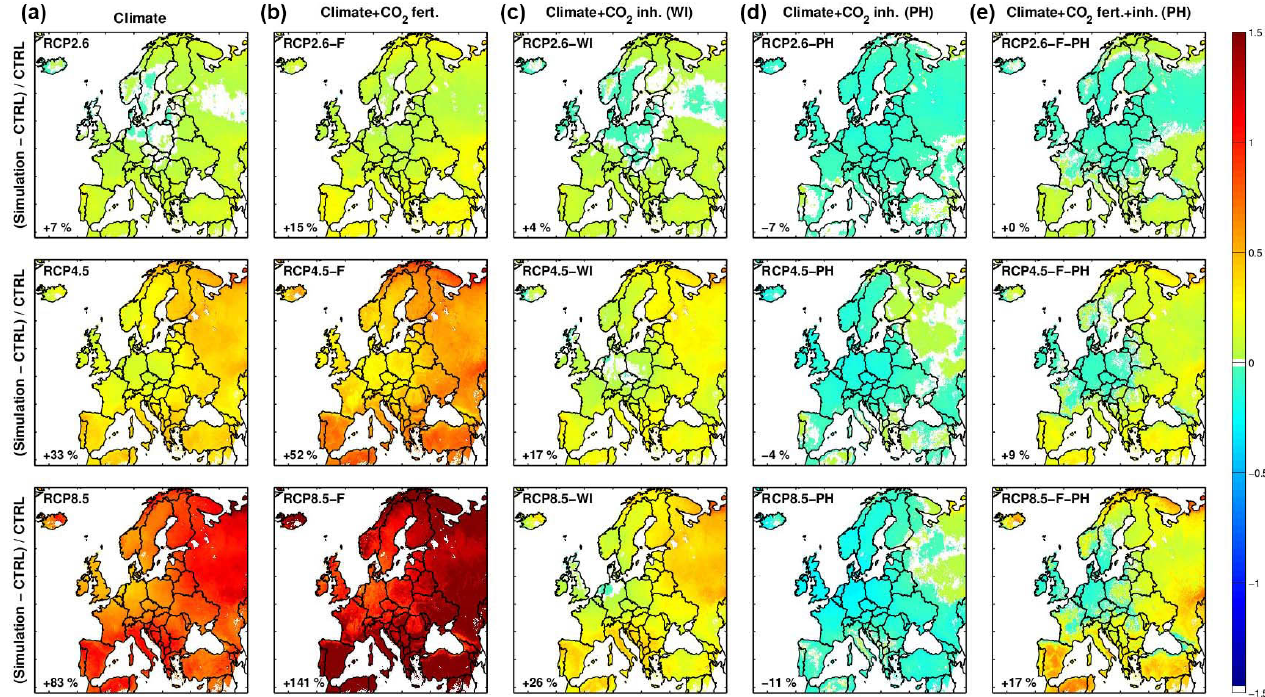
Figure 9. Relative differences in isoprene emissions between the control ALARO simulation (CTRL) and the three RCP scenarios consid- ering the effect of (a) climate (first column), (b) climate and CO 2 fertilization (second column), (c) climate and moderate CO 2 inhibition based on Wilkinson et al. (2009) (third column), (d) climate and strong CO 2 inhibition based on (Possell and Hewitt, 2011) (fourth column), and (e) climate, fertilization, and inhibition based on (Possell and Hewitt, 2011) (last column). The names of the simulations are given in the upper corner of each panel (see Table 1), and in the lower corner is given the relative change for the whole domain compared to the control simulation (CTRL), for which the mean isoprene flux is estimated at 4.6Tgyr − 1 (Table